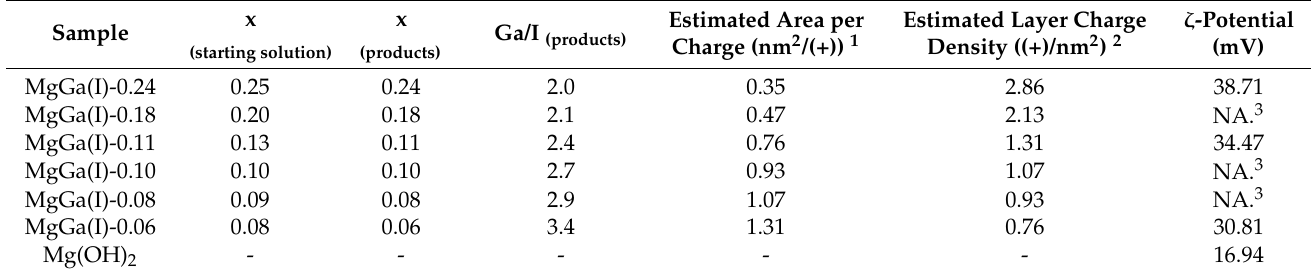
Table 1. Summary of the chemical composition, the estimated area per charge, the estimated layer charge density, and zeta potential of the products and the commercial brucite.